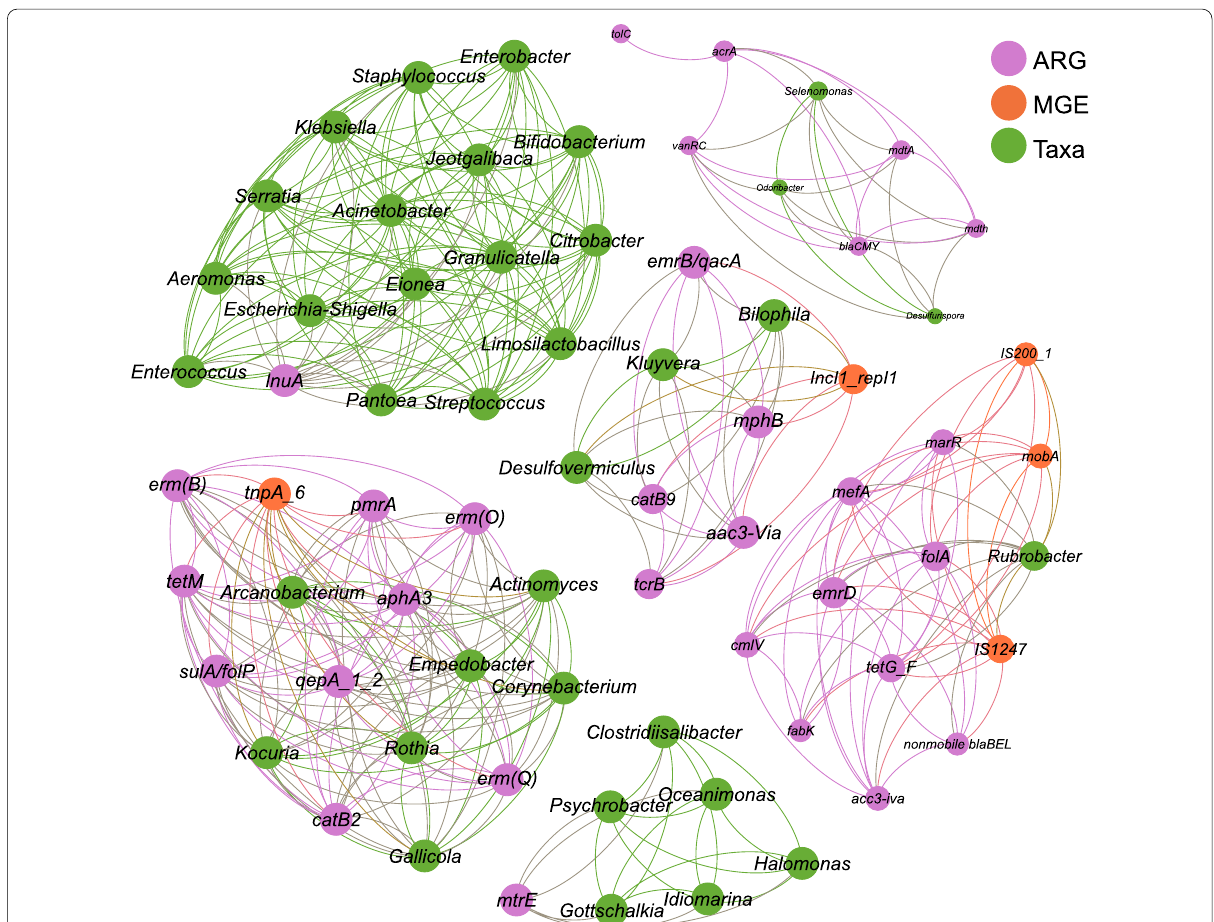
Fig. 10 Co-occurrence network between ARGs, MGEs, and bacterial genera identified in the Galapagos marine iguana’s gut. Node size represents the degree of